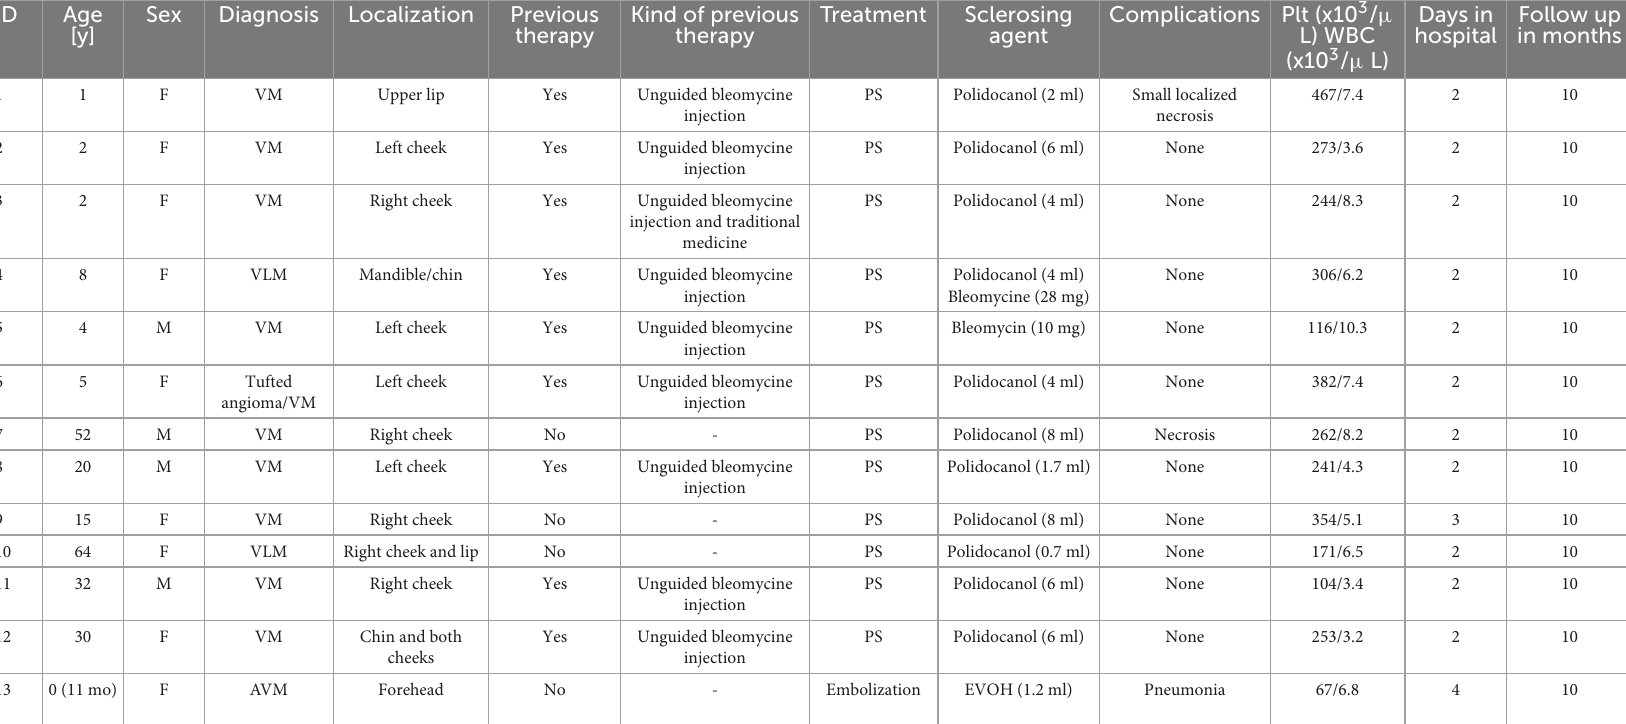
TABLE 1 Patient characteristics and procedural